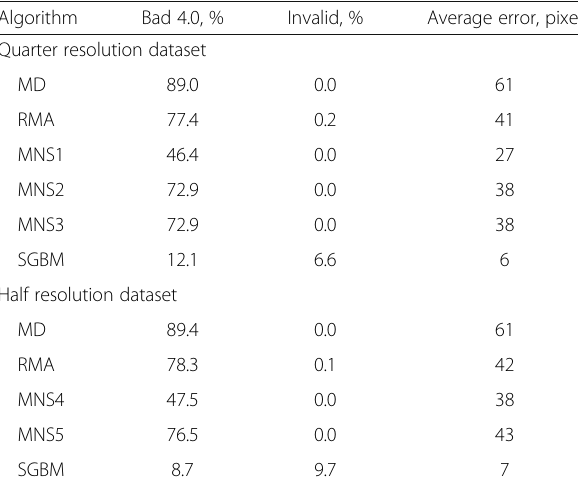
Table 6 The average quality measures of each algorithm performed on the Q and H resolution training sets images Algorithm